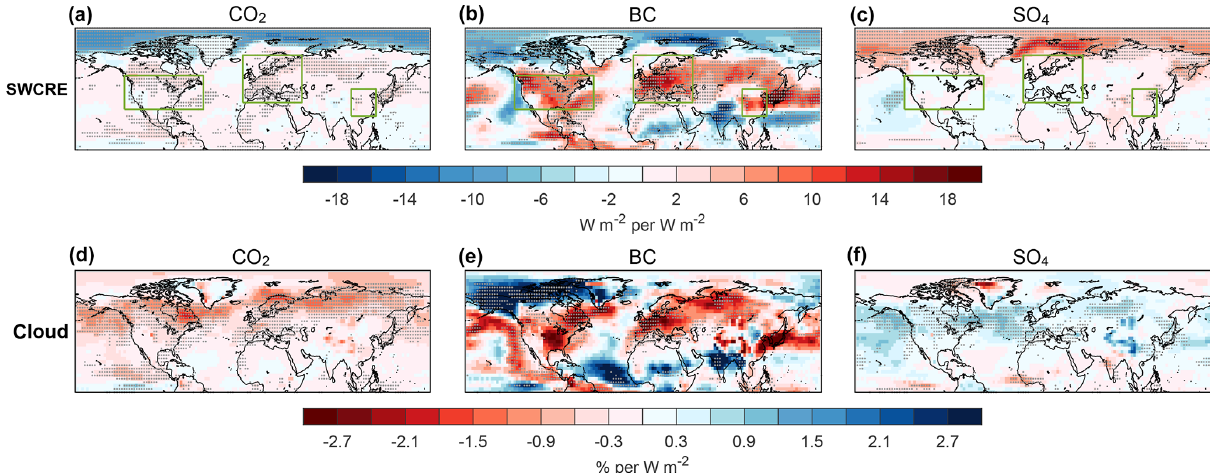
Figure 2. SWCRE changes (a–c) and cloud cover changes per unit forcing at 850hPa (d–f) in JJA; results for SO 4 are changes per negative forcing. Grey dots indicate that changes are significant at the 0.05 level. Positive anomalies in (a–c) indicate more radiation reaching the surface.